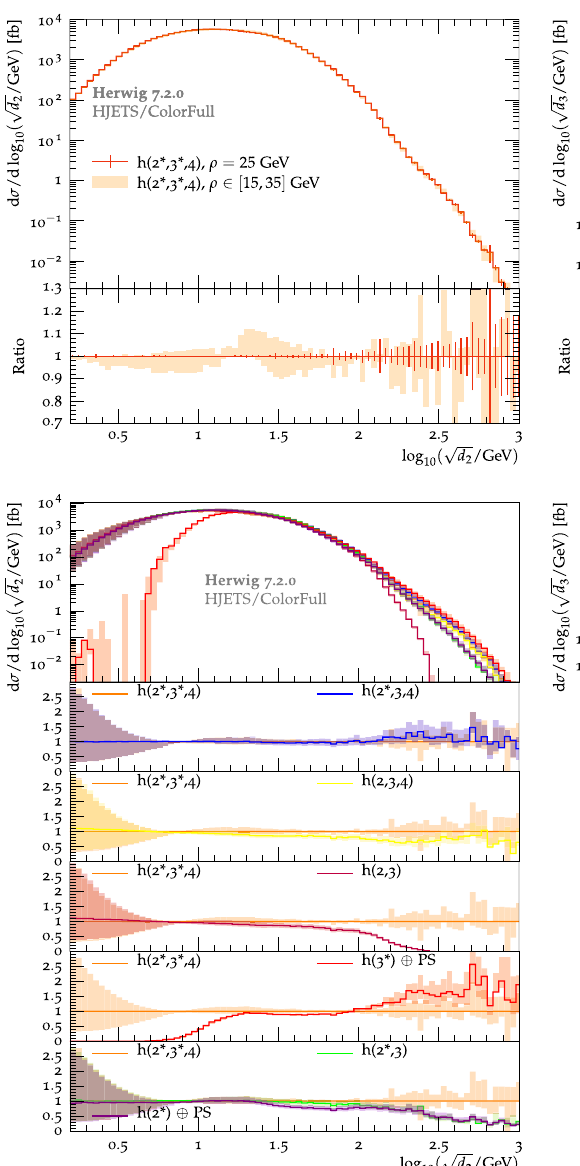
√ √ Fig. 4 Comparison plots for d 2 (left column) and d 3 (right col- momenta. This signals that the multi-scale approach inherent to the umn). Shown in the top row is the theory band resulting from vary- merging is more appropriate to such processes than using a fixed- ing the merging scale for the prediction of h ( 2 (cid:3) , 3 (cid:3) , 4 ) . Shown in the multiplicity, dynamic scale like the H T , jets scale we have been using bottom row are theory error bands resulting from the variation of the here. Also observe that additional hard jet matrix elements, like the four renormalization and factorization scales for predictions of h ( 2 (cid:3) , 3 (cid:3) , 4 ) , jet contribution, might well affect transition rates at lower jet multiplic- (cid:2) (cid:2) h ( 2 (cid:3) , 3 , 4 ) , h ( 2 , 3 , 4 ) , h ( 2 (cid:3) , 3 ) , h ( 2 , 3 ) , h ( 3 (cid:3) ) ity, a feature which has reportedly been observed in merged simulations PS, and h ( 2 (cid:3) ) PS even up to much more than a hand full of jets [76] and is a consequence with h ( 2 (cid:3) , 3 (cid:3) , 4 ) being the reference in the ratio plots. While for the observables we consider later the matched and merged three jet sim- ulations agree well within their uncertainties we here observe bigger differences for large jet separation scales and large third jet transverse